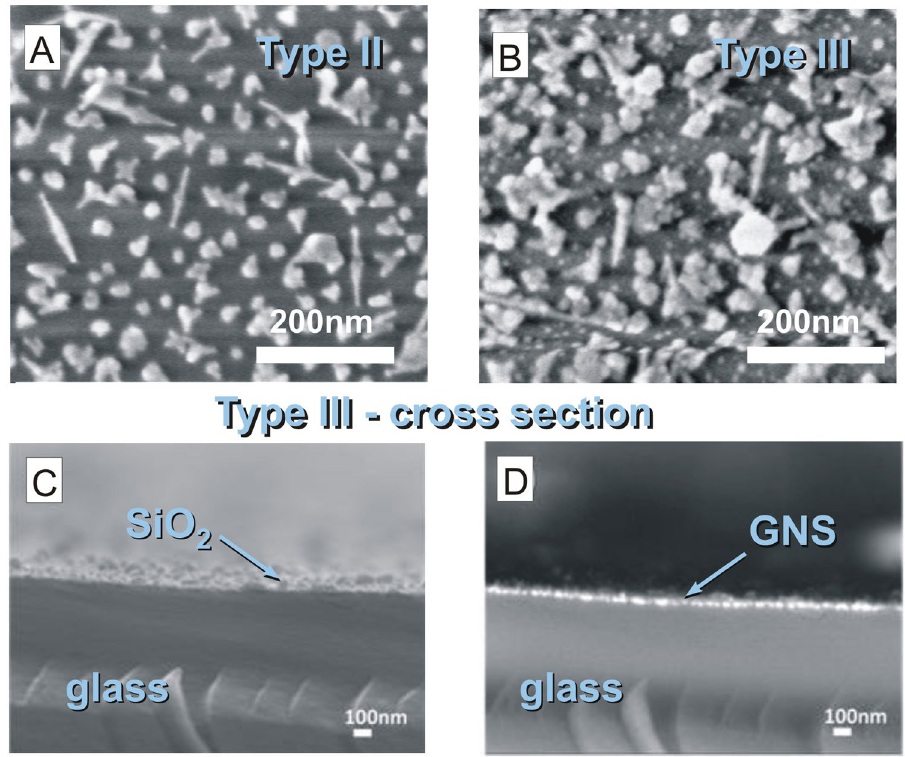
Figure 3. ( A ) HR-SEM image of Type II surfaces showing the morphology of GNS attached to the surface; ( B ) Type III surfaces showing AgNPs as small bright dots on top of the GNS monolayer. ( C , D ) SEM imaging of Type III slide cross-section showing ( C ) secondary electron detector topographic image and ( D ) backscattering electron detector (SEM BSD) image, with bright spots corresponding to the GNS monolayer (The sample is oriented upwards, from bottom to top: glass, GNS, SiO 2 ,